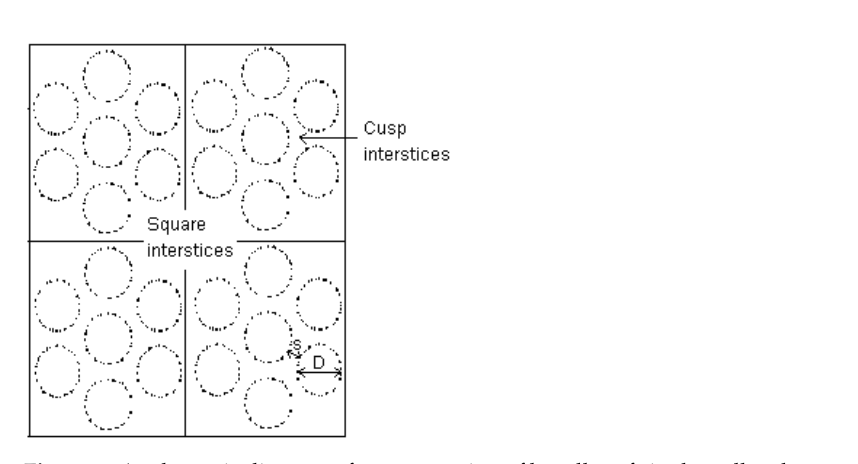
Figure 1. A schematic diagram of a cross section of bundles of single wall carbon nanotube (SWCN) and the minimum image convention used in this study.